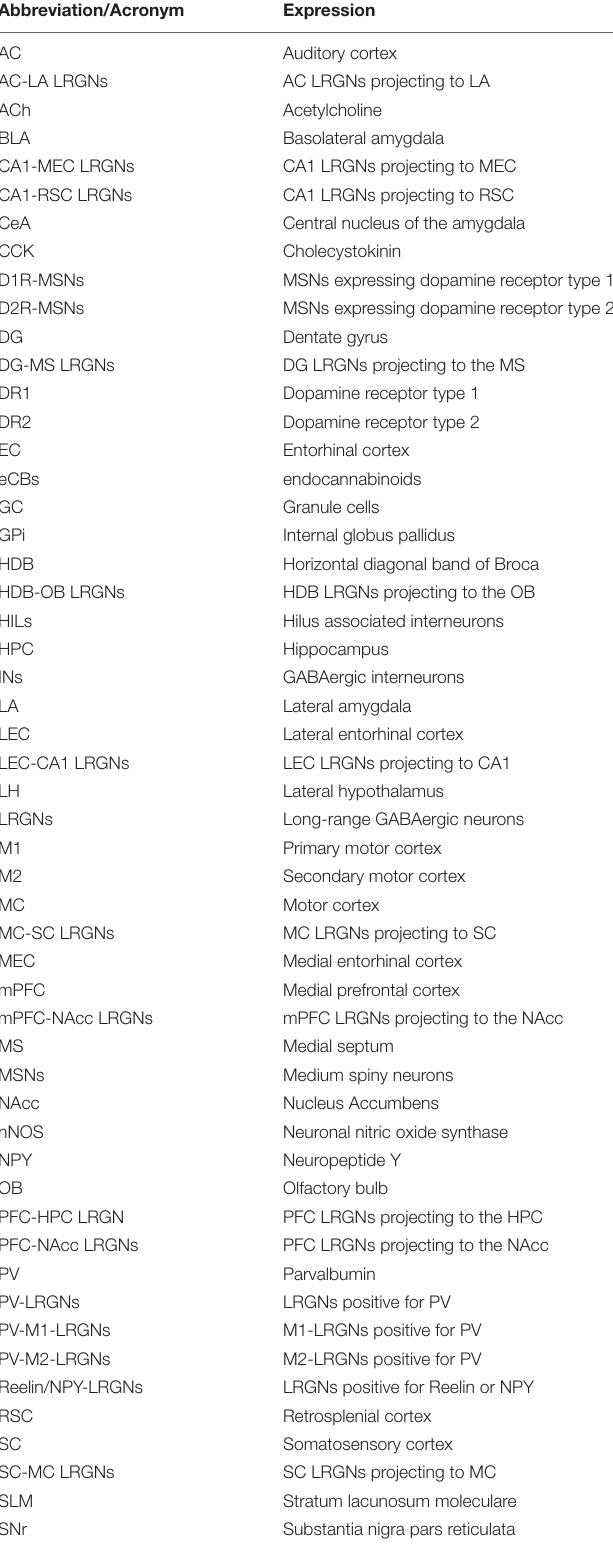
TABLE 1 | Abbreviations and acronyms used in this